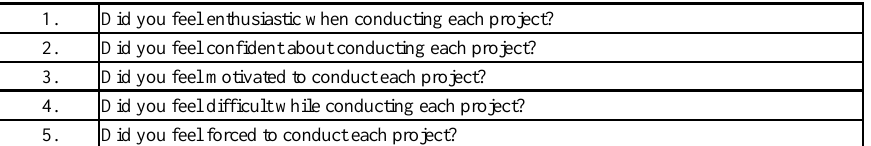
Table 2. Survey questions regarding students' attitudes, enthusiasm, and motivations on each